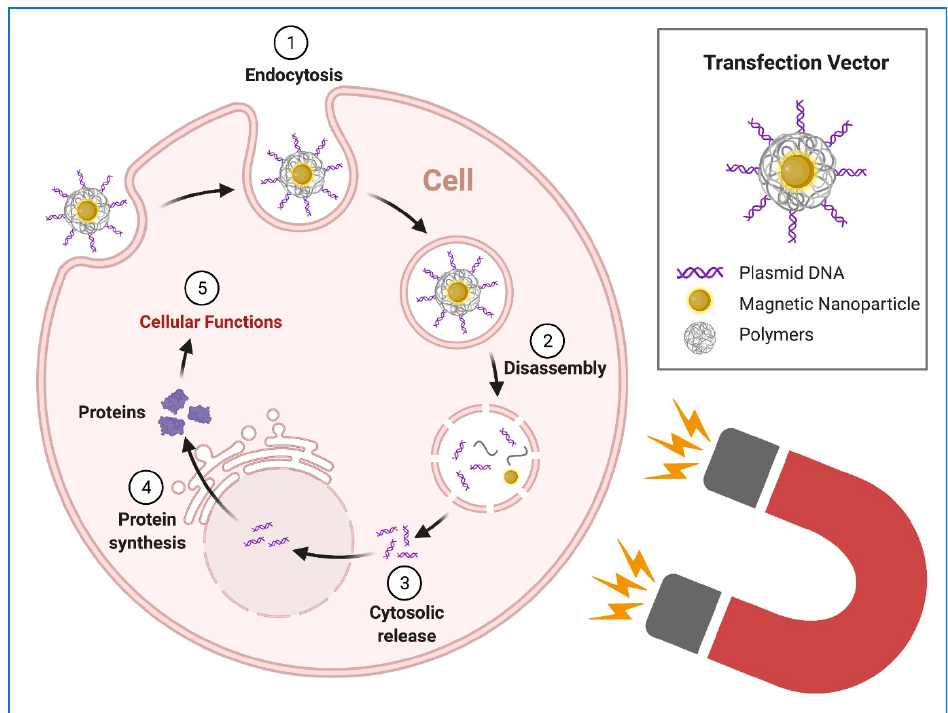
Figure 5. Magnetofection using magnetic nanoparticles. The plasmid DNA is associated with magnetic nanoparticles, which are directed, attracted and concentrated on the surface of cell membranes, where the endocytosis process brings the nanoparticles into the cell. Figure generated using BioRender.